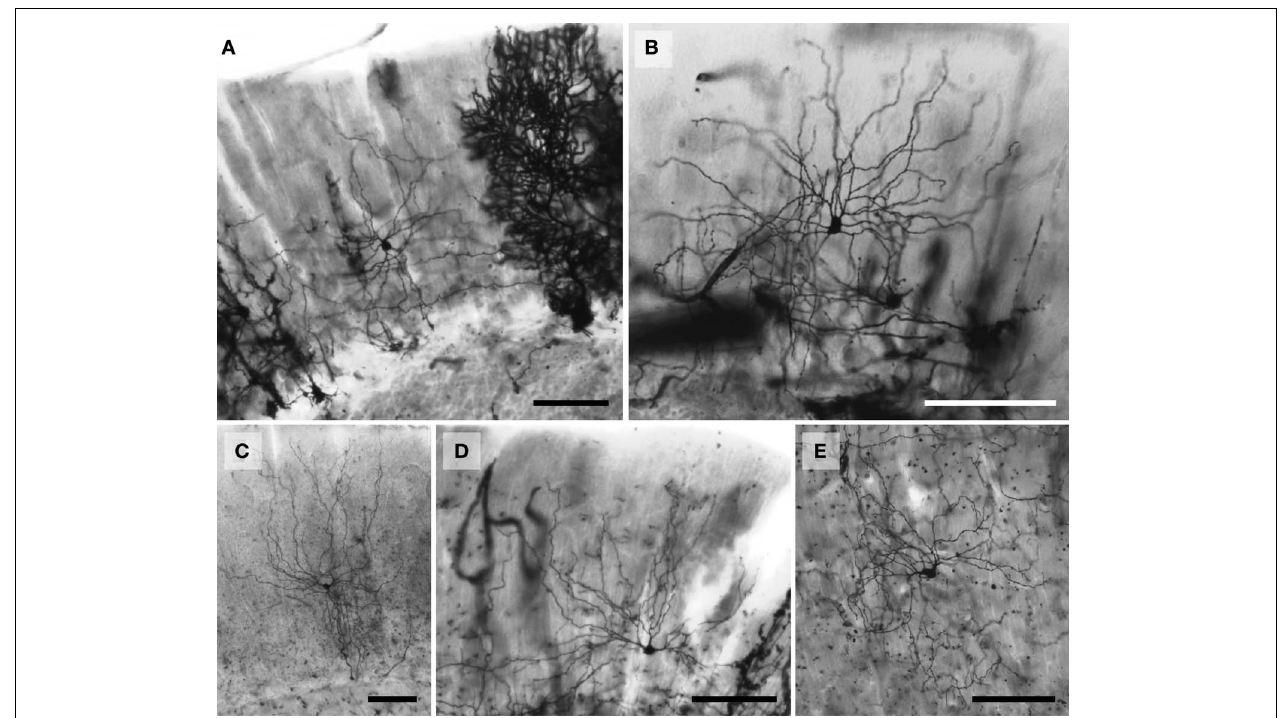
FIGURE 2 | Photomicrographs of Golgi-stained stellate neurons. (A) Florida manatee; (B) chimpanzee (see also Figure 11Q ); (C) human (see also Figure 11D ); (D) giraffe; and (E) African elephant (see also Figure 8C ). Scale bars: 100 μ m.